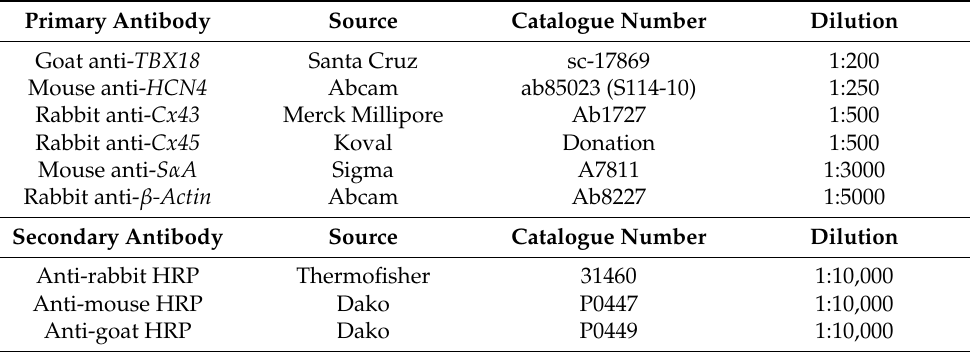
Table 2. Primary and secondary antibodies used in the immunoblotting